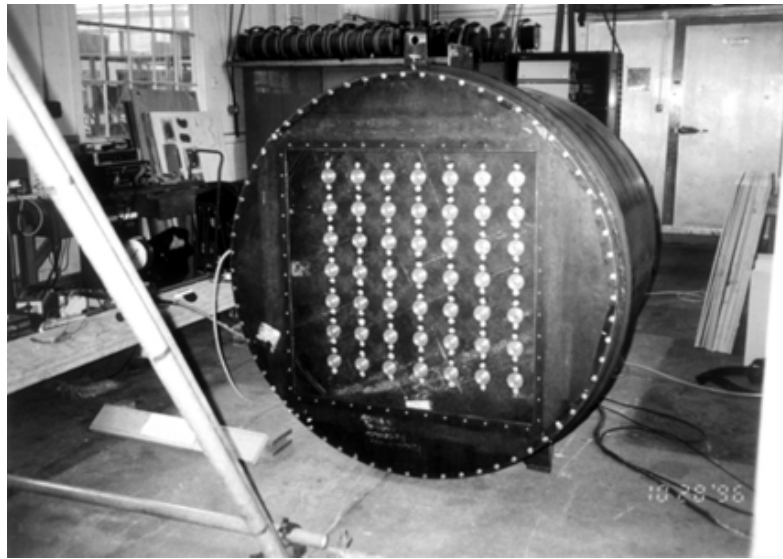
Fig. 9. Variable rate loading